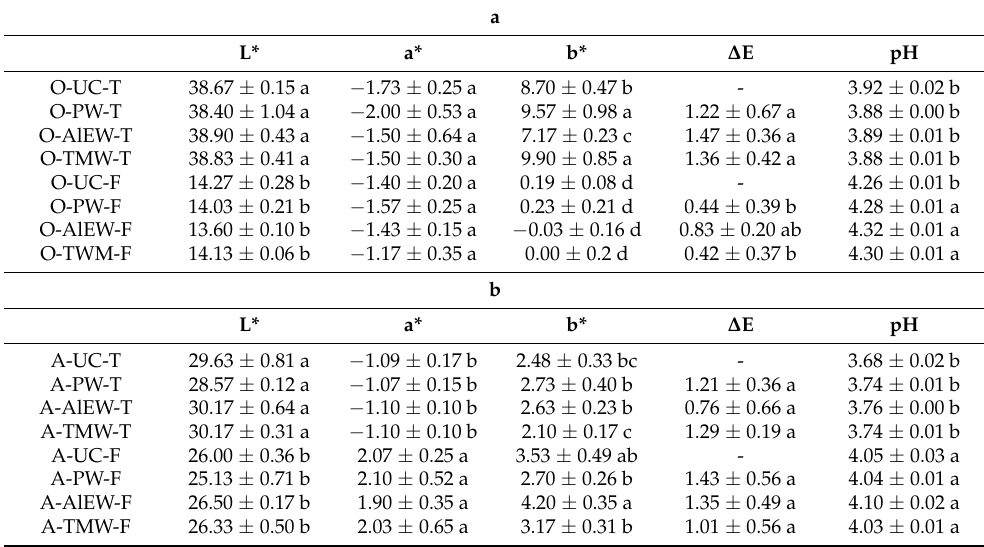
Table 2. The physical properties of orange juice 1